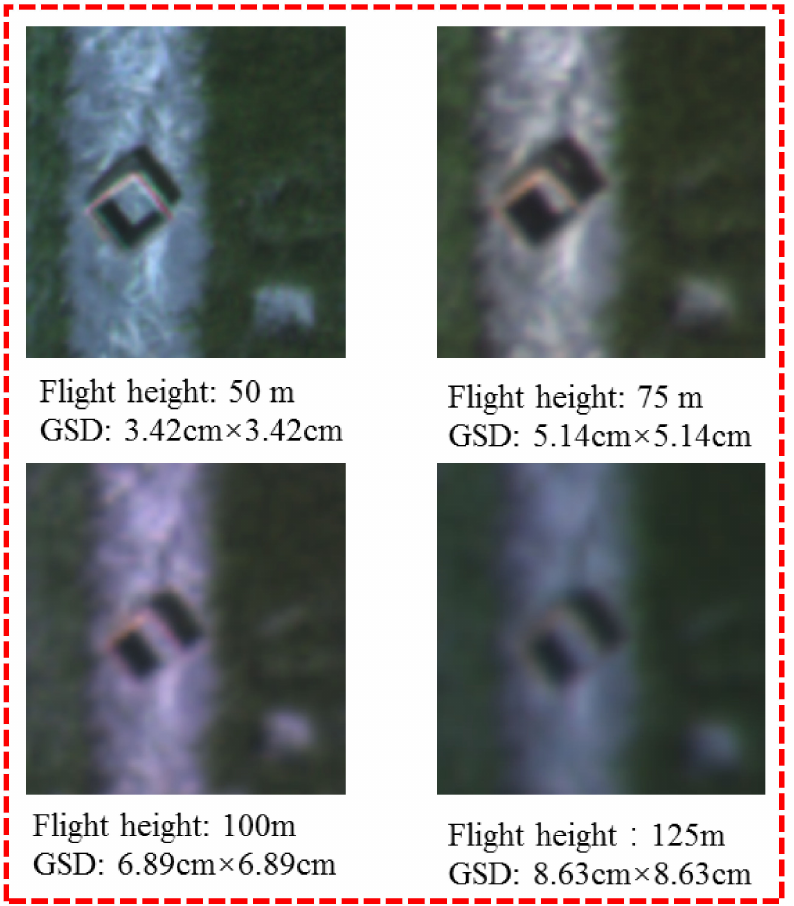
Figure 6. Local remote sensing images with different spatial resolutions (GSD: Ground Sam- pling